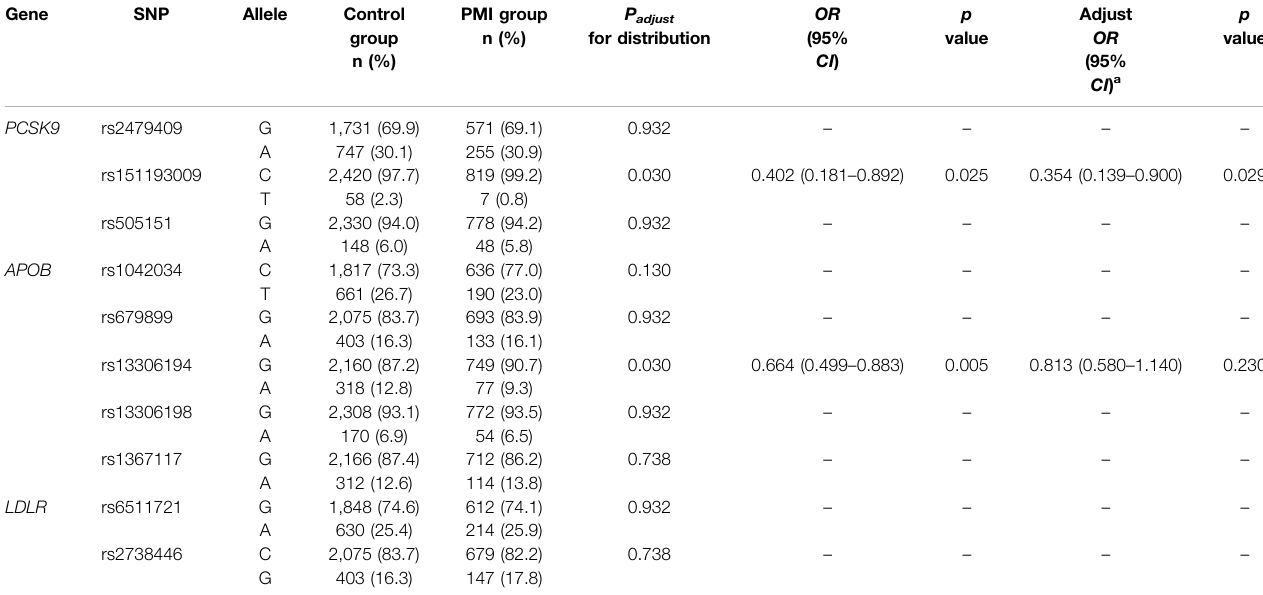
TABLE 2 | Distribution of alleles and the association between different SNPs and incidence of PMI in Cohort 1 in the dominant model. Gene